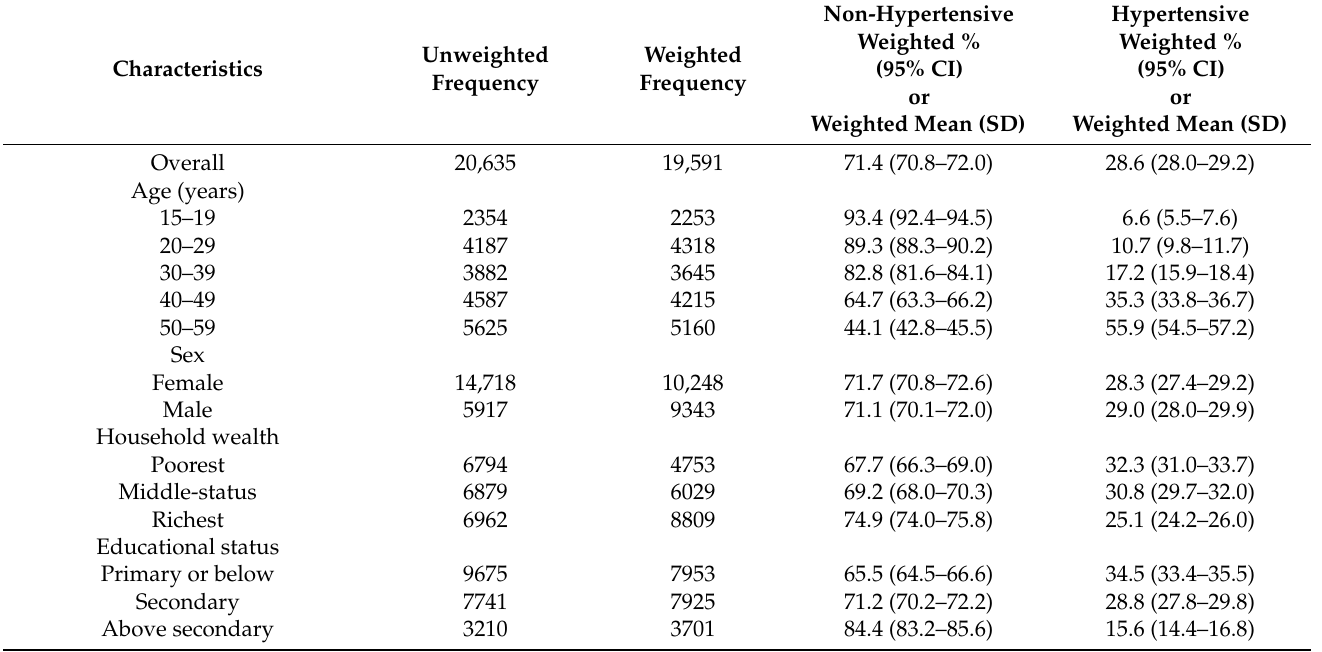
Table 1. Sample characteristics by hypertension